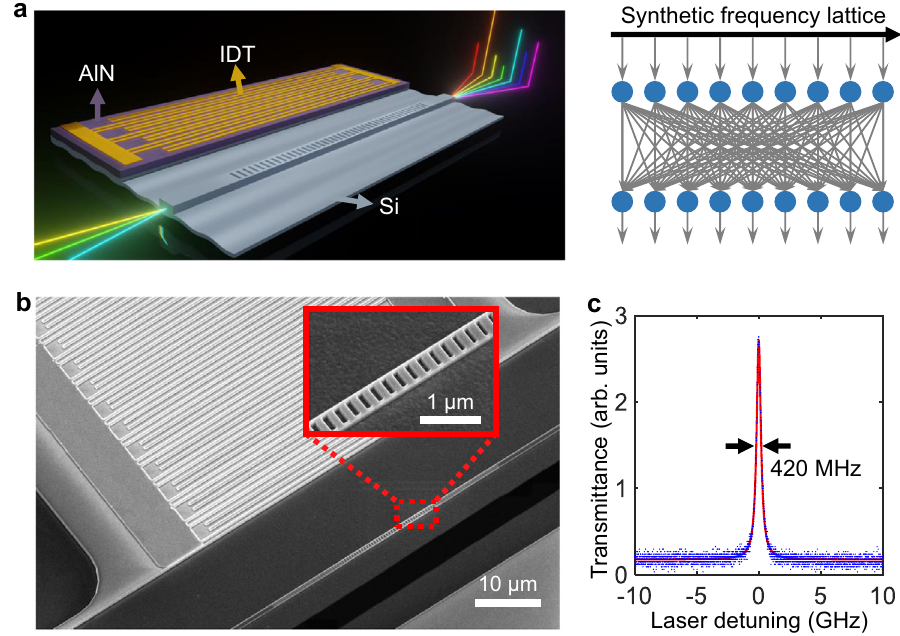
b SEM image of the modulator fabricated on the AlN-on-SOI platform. Inset is the zoom-in image of the nanophotonic cavity. c Measured optical transmission spectrumwithoutmodulation,showingalinewidthof420MHz.Thecenteroptical resonance wavelength is around